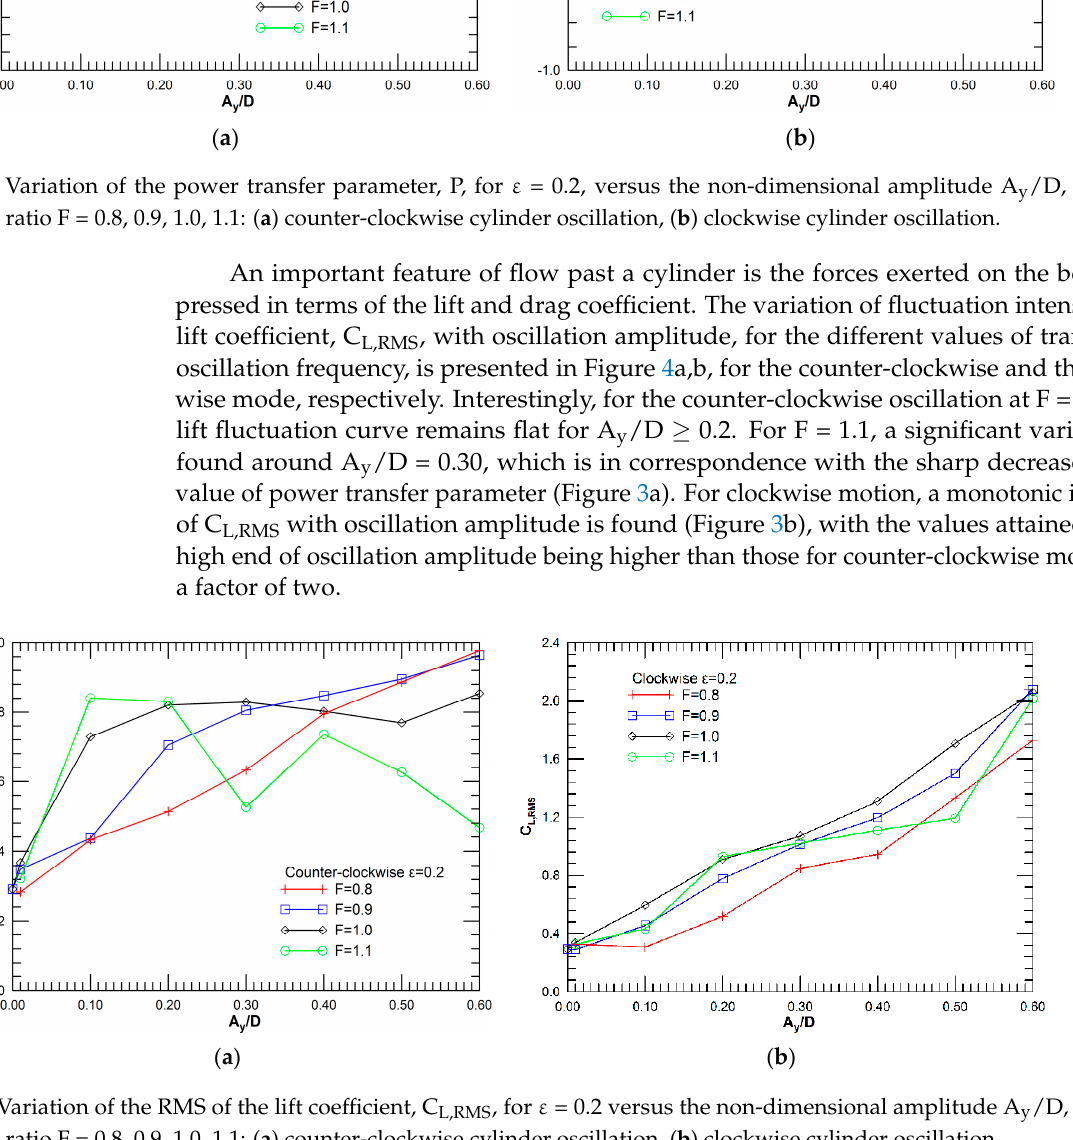
( b ) Figure 5. Variation of the mean drag coefficient, <C D >, for ε = 0.2, versus the non-dimensional amplitude A y /D, for fre- quency ratio F = 0.8, 0.9, 1.0, 1.1: ( a ) counter-clockwise cylinder oscillation, ( b ) clockwise cylinder oscillation.